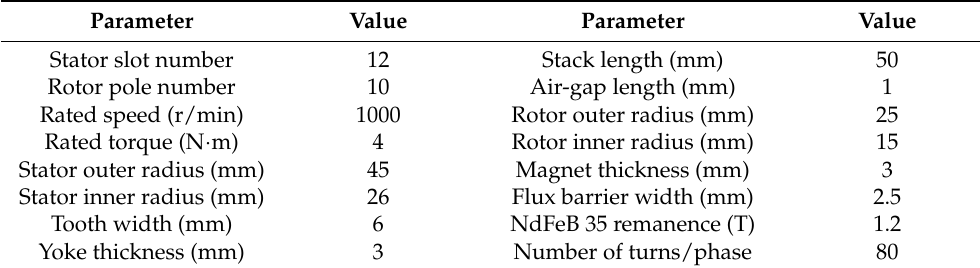
Figure 1. Cross sections of 12-slot/10-pole dual three-phase machines. ( a ) DL-TSM. ( b ) SL-TSM. ( c ) SL-ATM. ( d ) SL-ABM. Table 1. Main Machine